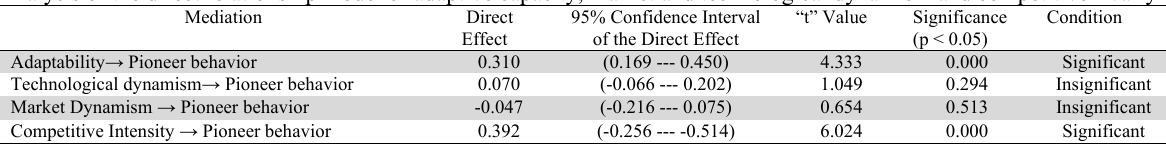
Analysis of the direct relationship model of adaptive capacity, market and technological dynamism and competitive rivalry